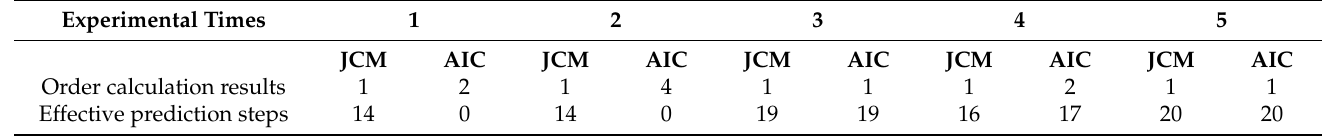
Table 1. Comparison results of the model order joint calculation system effectiveness